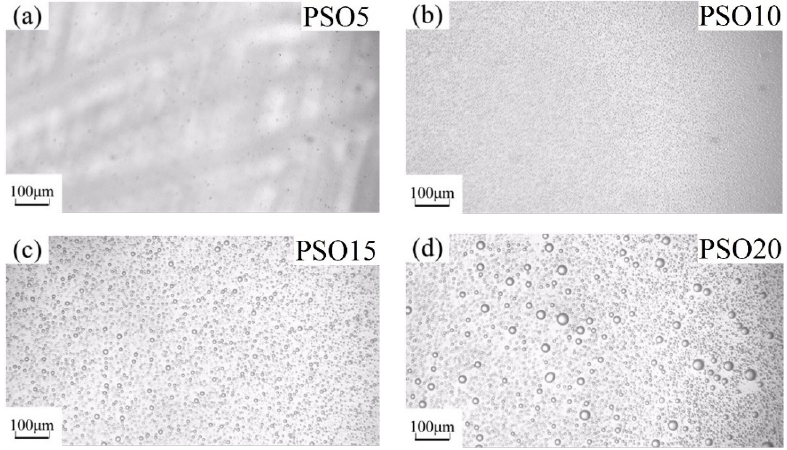
Figure 3. Morphology of different silicone oil/PDMS mixtures: ( a ) macroscopic images; ( b ) OM images. The silicone oil droplets changed when increasing silicone oil’s concentration in PDMS, which is shown, respectively, for PSO/PDMS and FSO/PDMS mixtures in Figure 4 and Figure 5. The immiscible silicone oil droplets can be seen clearly in the blend solu- tion under the microscope. Furthermore, the size of the droplets became larger after in- Figure 4. OM images of PSO/PDMS mixtures: ( a ) PSO5, ( b ) PSO10, ( c ) PSO15, ( d ) PSO20. creasing the concentration of silicone oil. The size of FSO droplets was larger than that of PSO droplets, due to the weaker compatibility of FSO with PDMS.